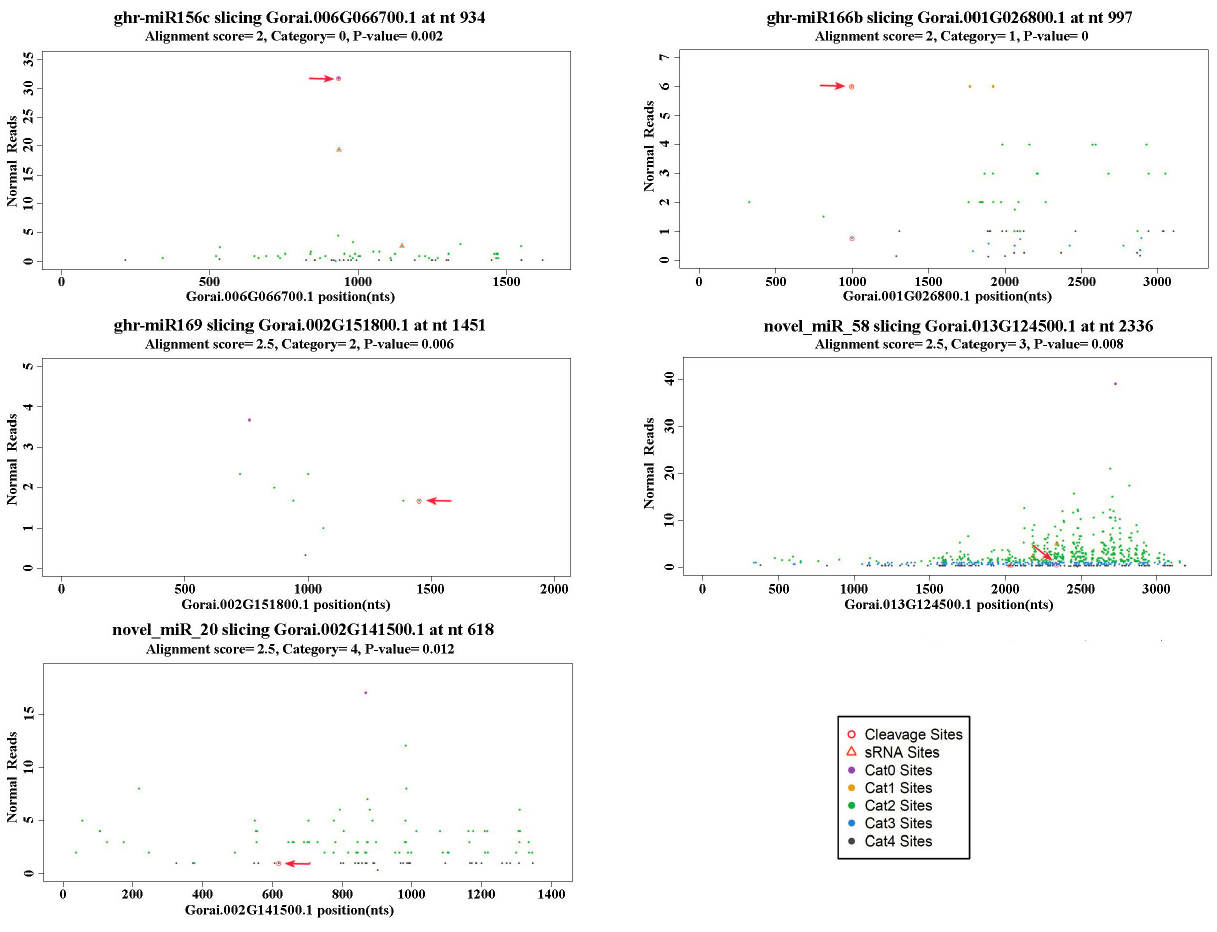
Figure 4. Target plots (t-plots) of the representative miRNA targets in different categories confirmed by using degradome sequencing. Normal Reads: repeat normalized number of 5 ′ ends at that position for target gene. Red arrows indicate the target genes cleavage sites. Table 3. Target genes of novel miRNAs identified by degradome sequencing in cotton. Norm Cleavage miRNA Target Gene Categoty Site